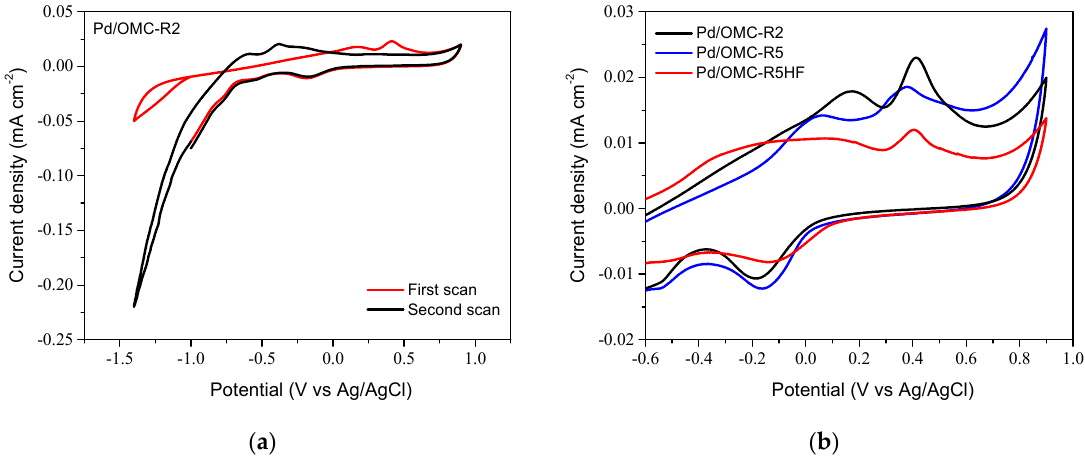
Figure 7. Reduced CO 2 stripping voltammograms of Pd/OMC catalysts in 0.1 M KHCO 3 ( v = 10 mV s − 1 , E ad = − 1.0 V vs. Ag/AgCl): ( a ) Pd/OMC-R2; ( b ) Comparison of the first scan of Pd/OMC catalysts.